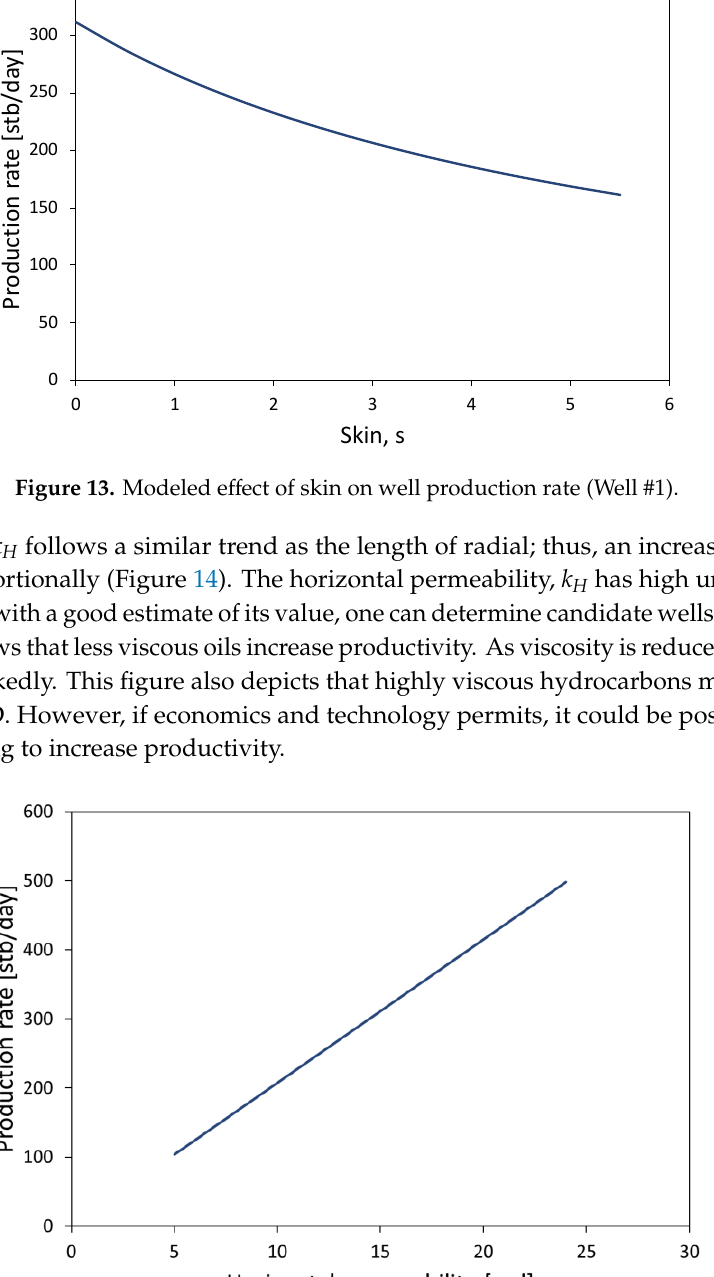
Figure 12. Modeled effect of lateral radius on well production rate (Well #1).